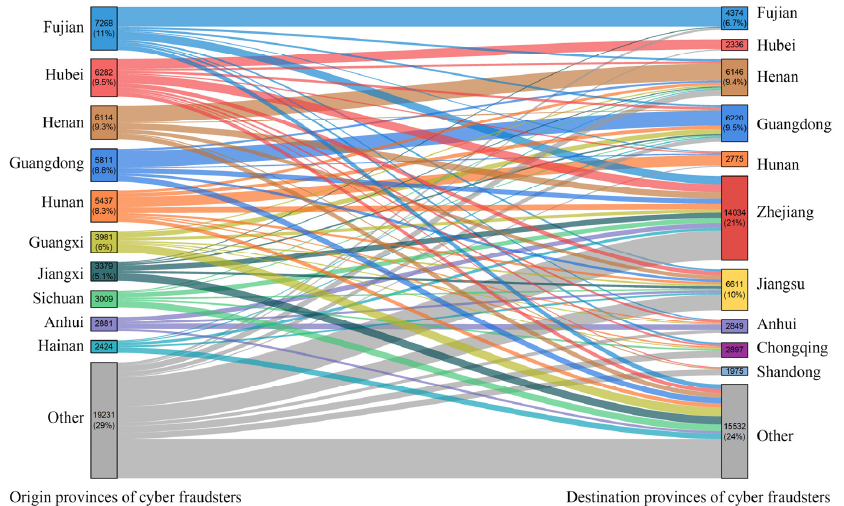
Figure 2. Spatial flow of cyber fraud offenders in China.